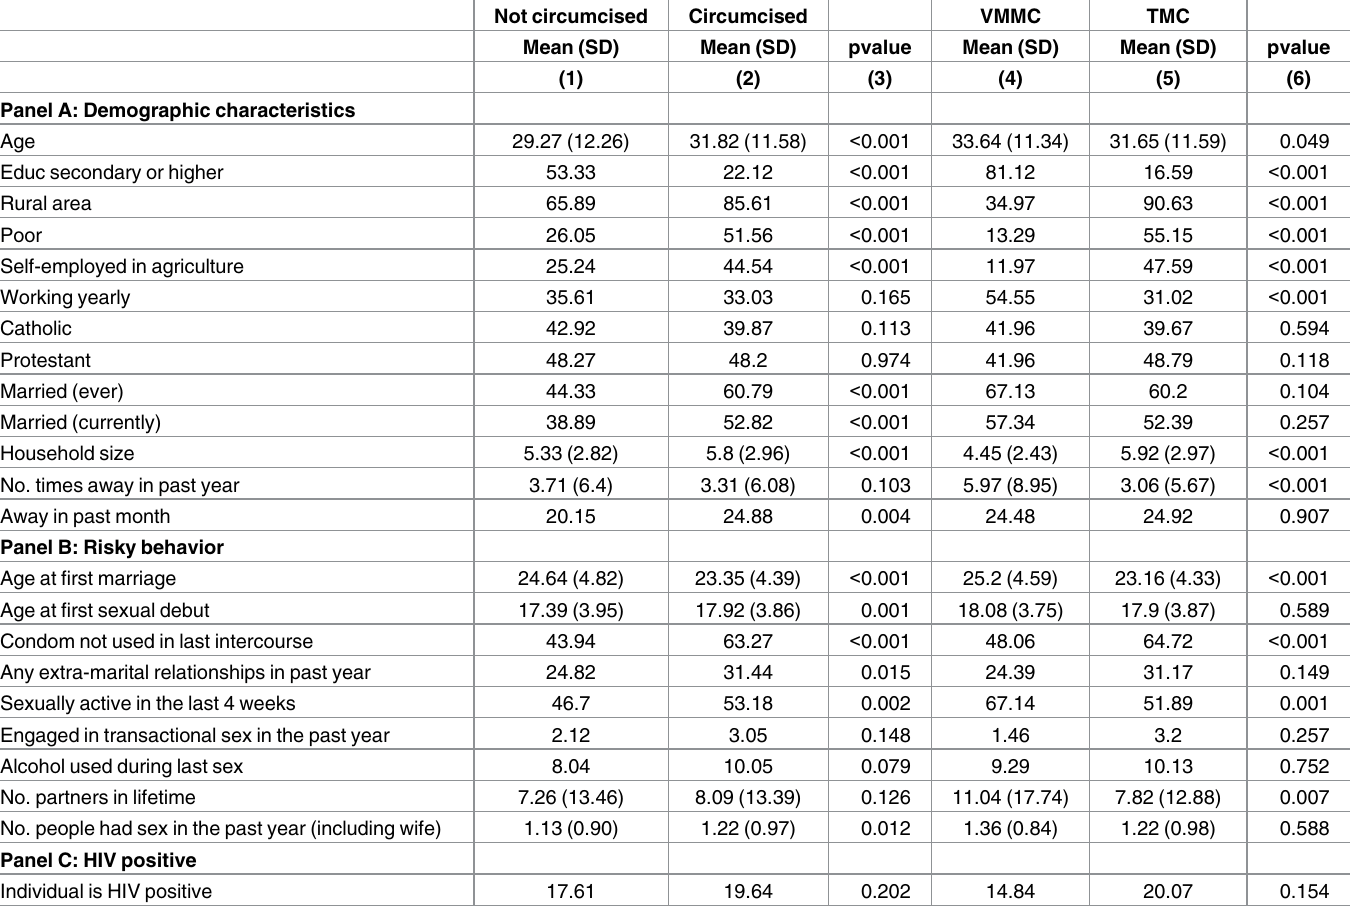
Table 3. Respondents’ characteristics by male circumcision status and type of